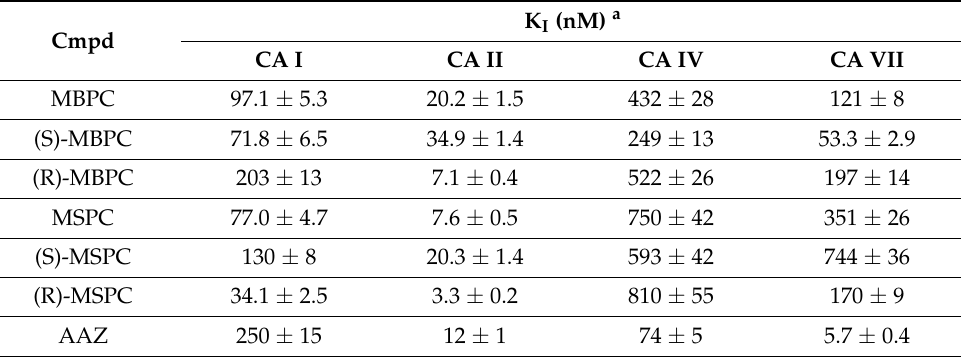
Table 4. Inhibition data of human carbonic anhydrase (CA) isoforms I, II, IV, and VII for of 3-methylpropyl(4-sulfamoylphenyl)carbamate (MBPC) and the standard sulfonamide inhibitor ac- etazolamide (AAZ) by a stopped-flow CO 2 hydrase assay. The inhibition data previously reported for 3-methylpentyl(4-sulfamoylphenyl)carbamate (MSPC). are also shown. K I (nM) Cmpd